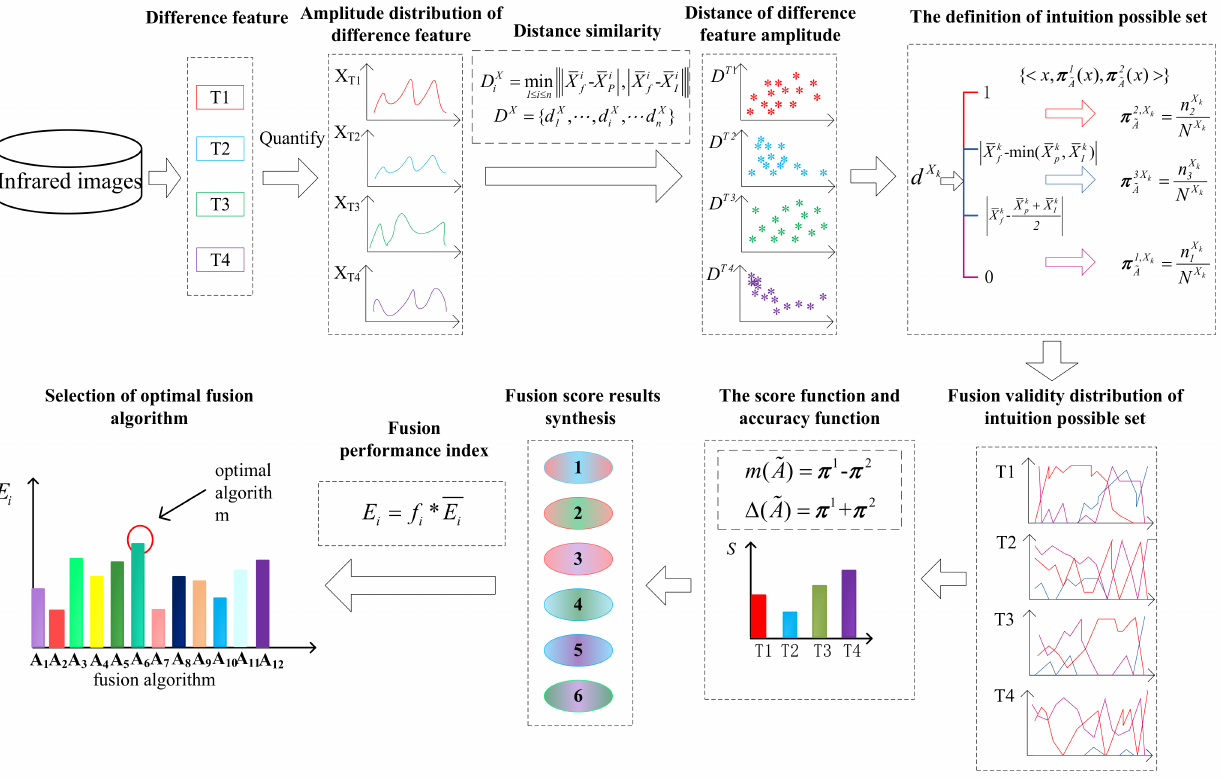
Figure 1. Flowchart of the proposed method. Table 1. The descriptions of particular